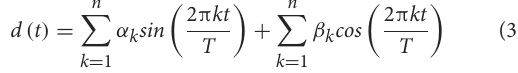
Table 3 indicates whether there is a Fourier function in the time series model for each country. Rejection of the null hypothesis implies that γ 1 and γ 2 equal to zero is rejected for all the countries. In this case, both gradual and sharp breaks are taken into account. The findings provide significant evidence for the existence of a Fourier function in the model ( p -value < 0.10). The Fourier function is employed to investigate the relationship between globalization and CO 2 emissions by performing cointegration and causality tests for the United States, China, and India. is applied to explore the long-term relationship between globalization and CO 2 emissions for the three CO 2 -emitting counties. It is based on error-correction models without restrictions, where the optimal order of the lags for the variables is determined according to the Akaike and Schwarz information criteria used in other empirical studies (49, 51, 57, 58).